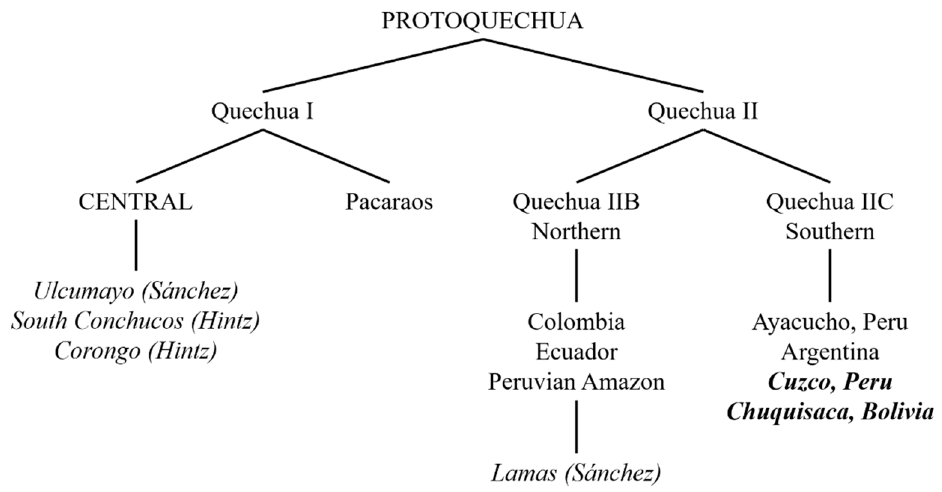
Figure 1. The Quechua language family and varieties from the studies mentioned. Bold italics indicate those under current study; other varieties studied by Sánchez (2003) and Hintz (2009) are simply italicized.